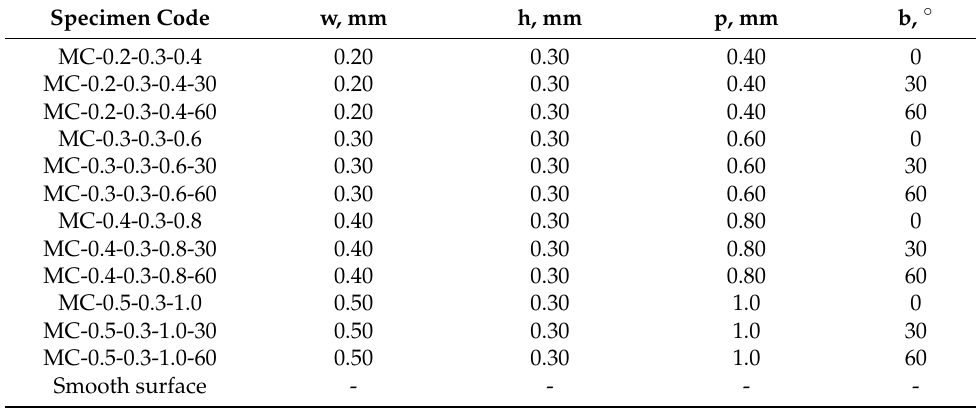
Figure 3. Dimensions of characteristically tested surfaces.